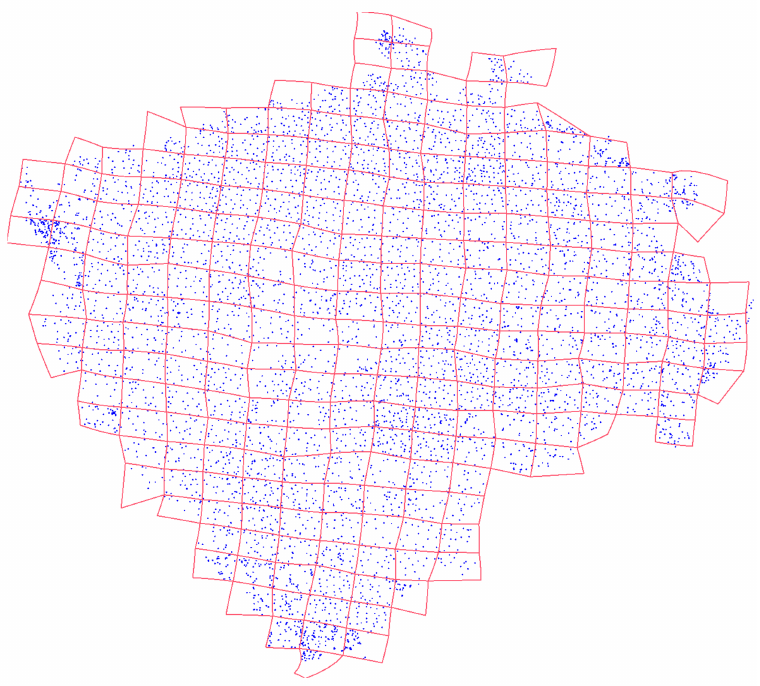
Figure 2. Mosaic of map sheets with marked position of